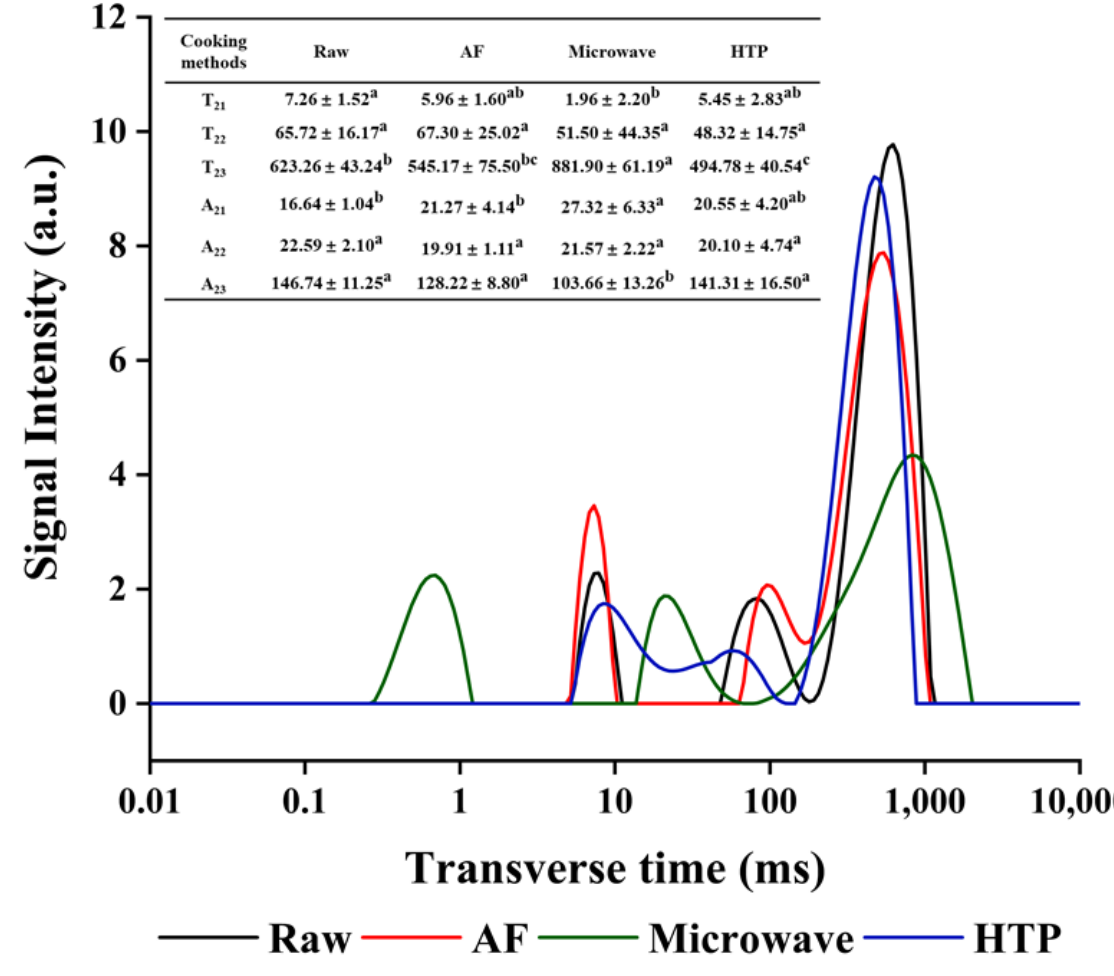
Figure 1. Representative T 2 relaxation spectra of UP treated with different cooking methods. Different letters in the same row for different cooking methods indicate significant differences at ( p ≤ 0.05).